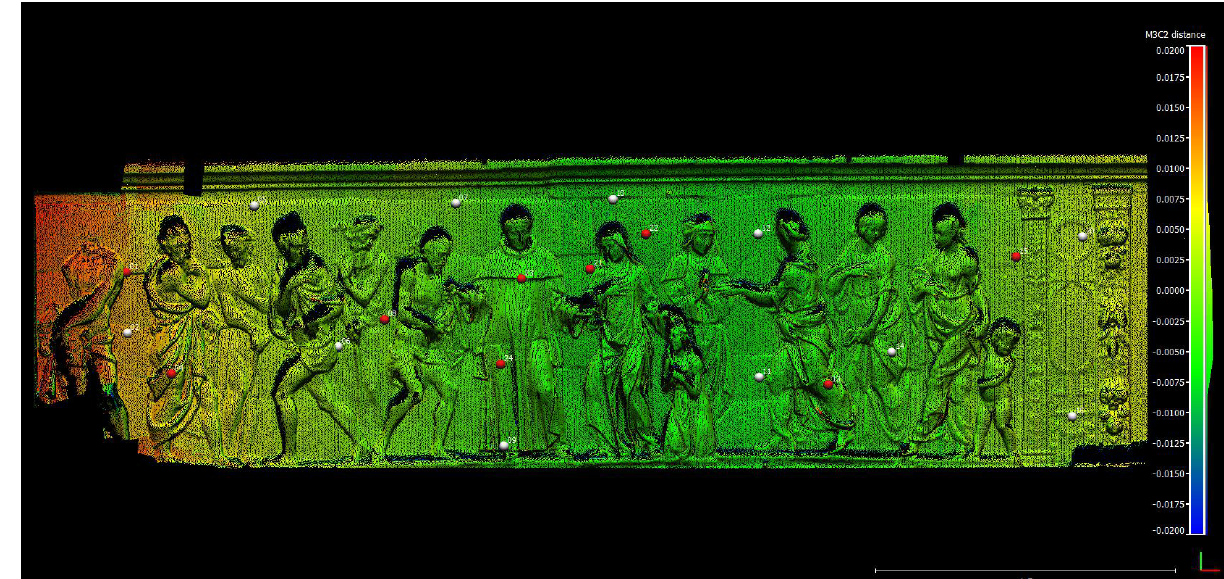
Figure 9. Comparison between the (reference) scan data and the photogrammetric dense cloud – GCPs are used in an optimization process (GCPs in white, CPs in red) - Step